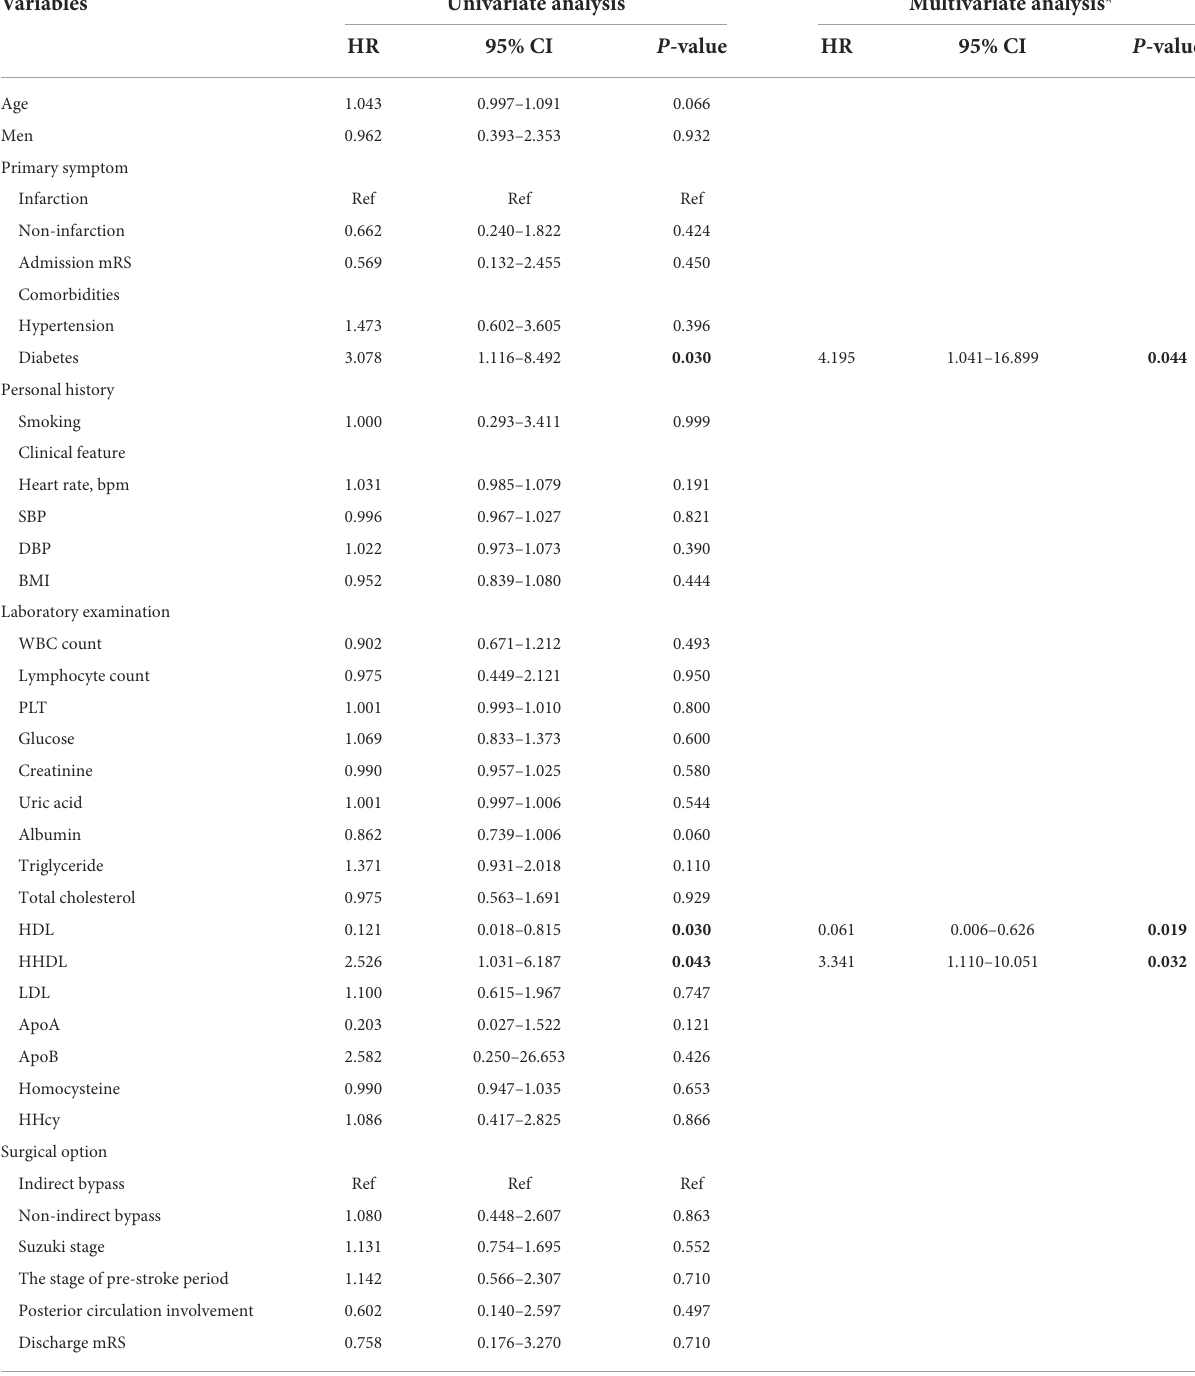
TABLE 5 Univariate and multivariate Cox regression analysis for recurrent